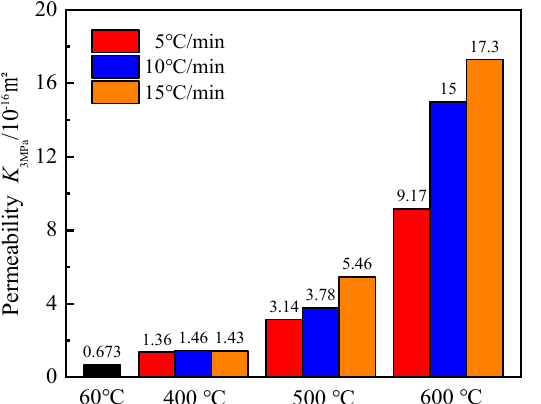
Figure 3. Variations in initial permeability with temperature and heating rate (Inset: permeability with respect to reference temperature 60 °C).